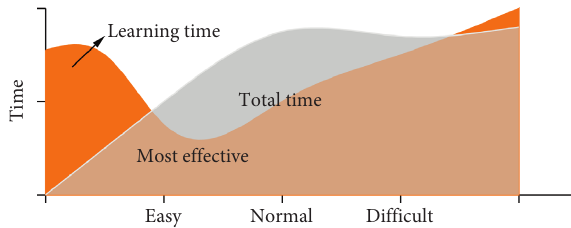
Figure 4: Question-answer difficulty